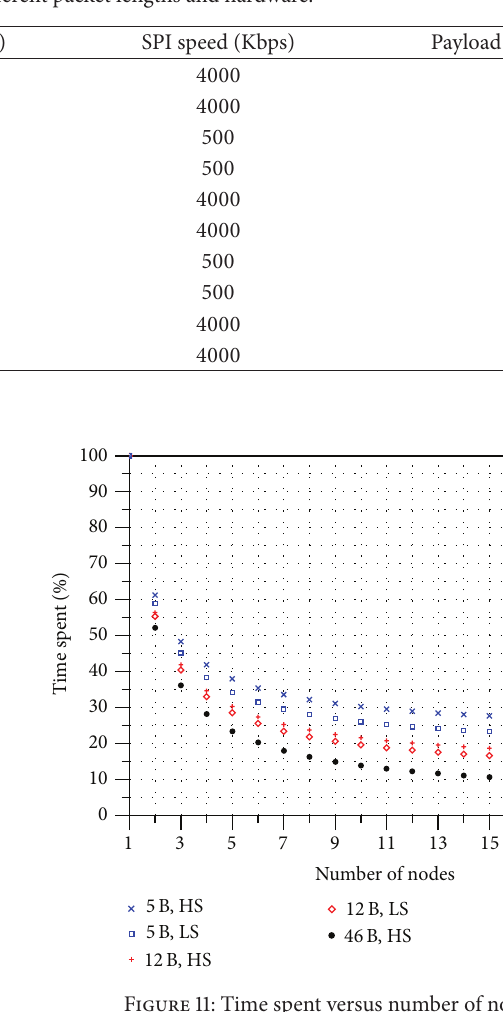
Figure 11: Time spent versus number of